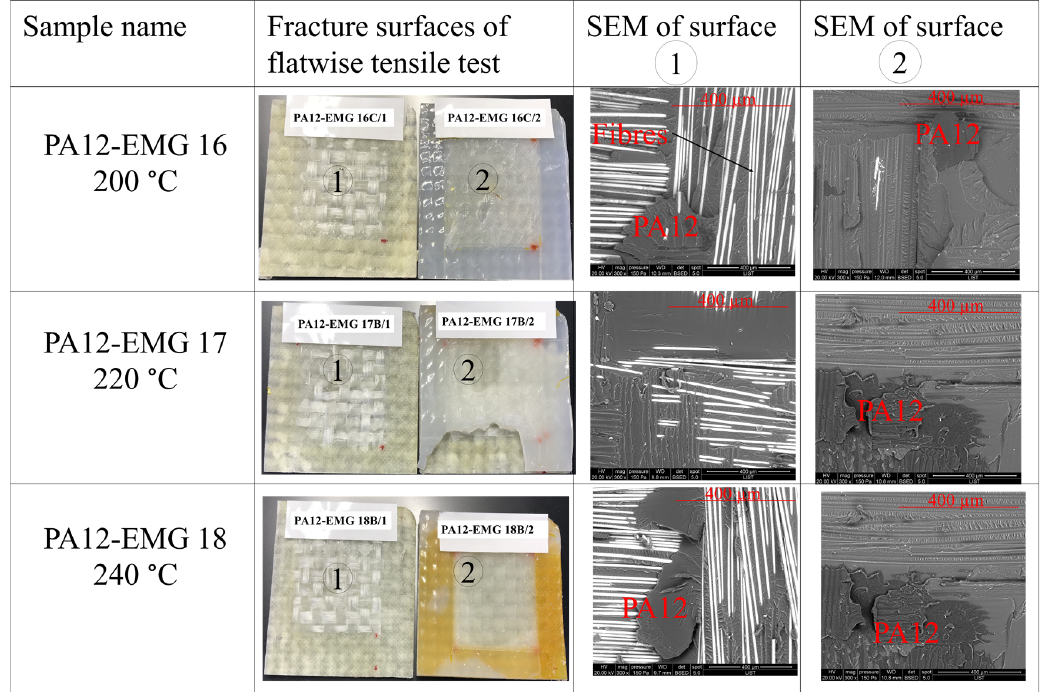
Figure 9. Fracture surfaces and SEM images of PA12-EMG specimens welded at temperatures of 200 °C, 220 °C, and 240 °C. The surface 1 stands for the EMG composite and the surface 2 stand for the interposed PA12 sheet.